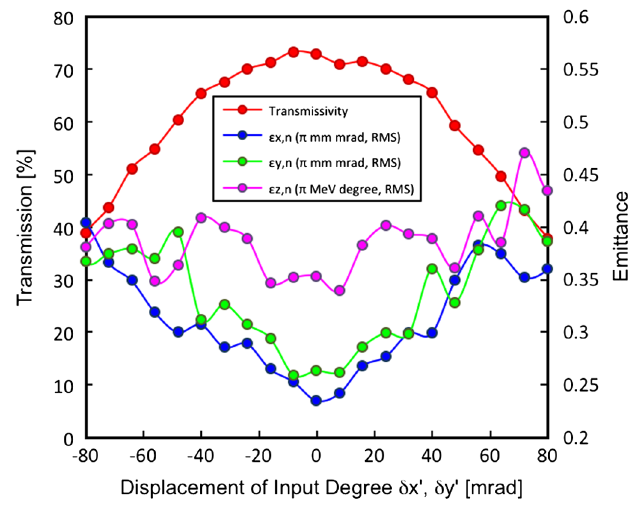
FIG. 14. Transmission and output emittance as a function of angle error of input beam to the